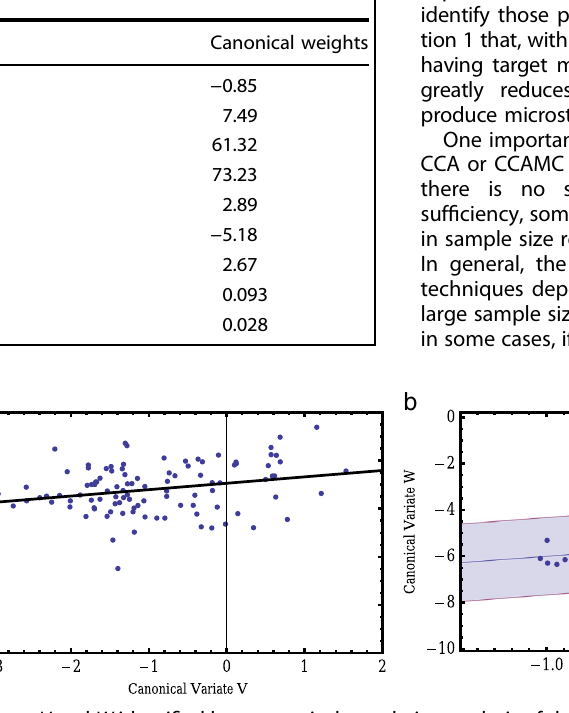
Fig. 4 a The canonical variates V and W identi fi ed by a canonical correlation analysis of the 104 data points from Application 2. The regression line is also shown. b The same as for part a, except that these results are obtained after Monte Carlo simulation. Note the stronger dependence between the two variates as compared to those shown in a . Also shown are the corresponding regression line and a 95% con fi dence interval for the data ( shaded region ). The correlation coef fi cient is